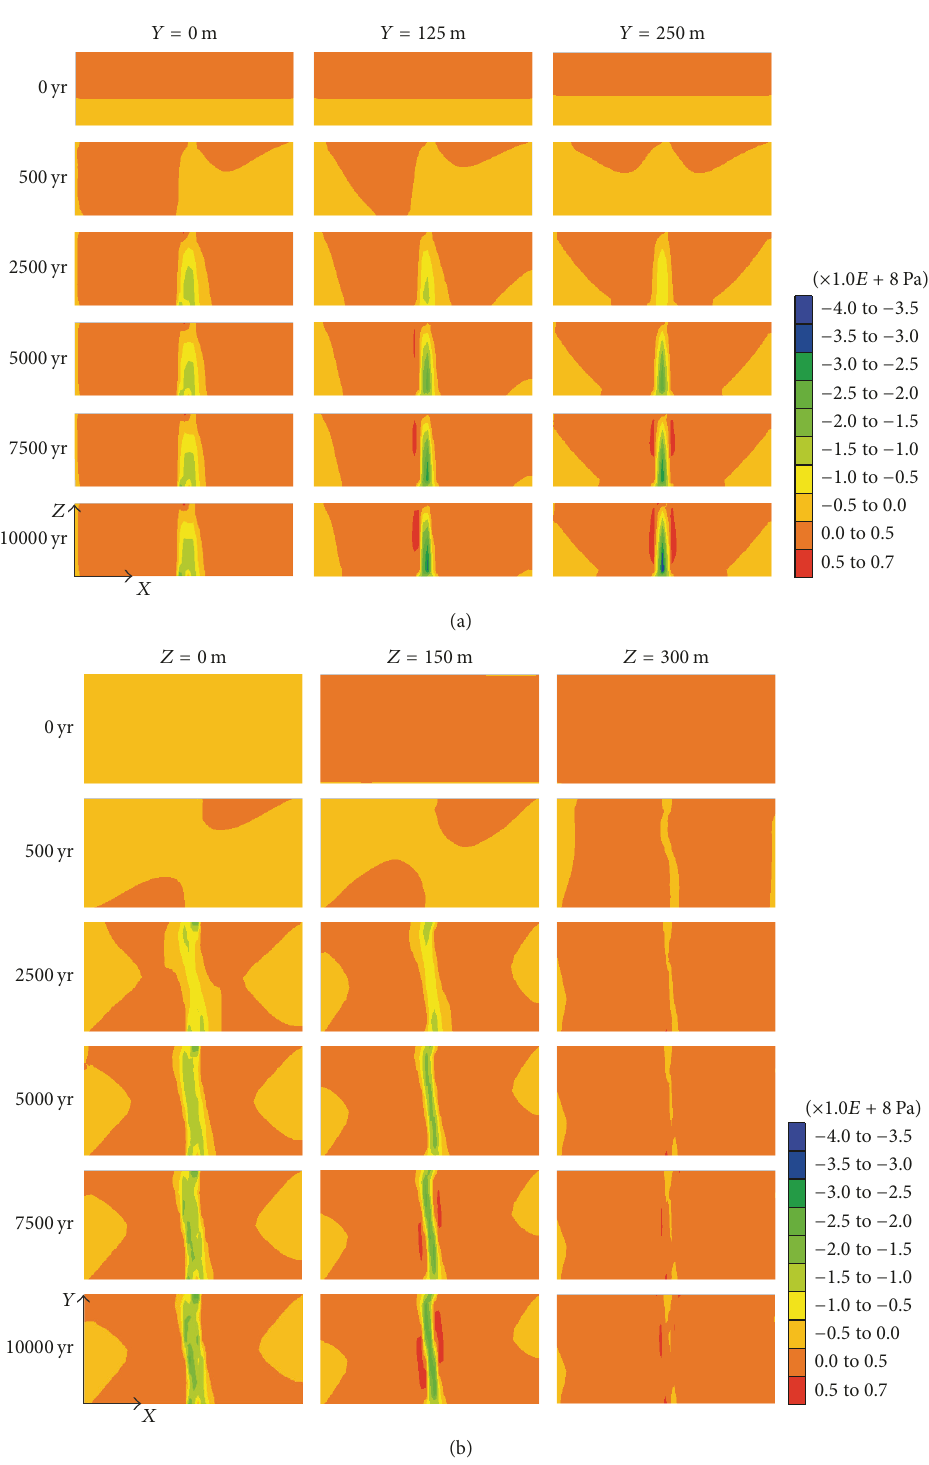
Figure 2: Contour map of the maximum principle stress ( 𝑆 max ) for Model I at different times. (a) is three vertical cross sections of 𝑌 = 0 , 125 m, and 250 m; (b) is three horizontal cross sections of 𝑍 = 0 , 150m, and 300